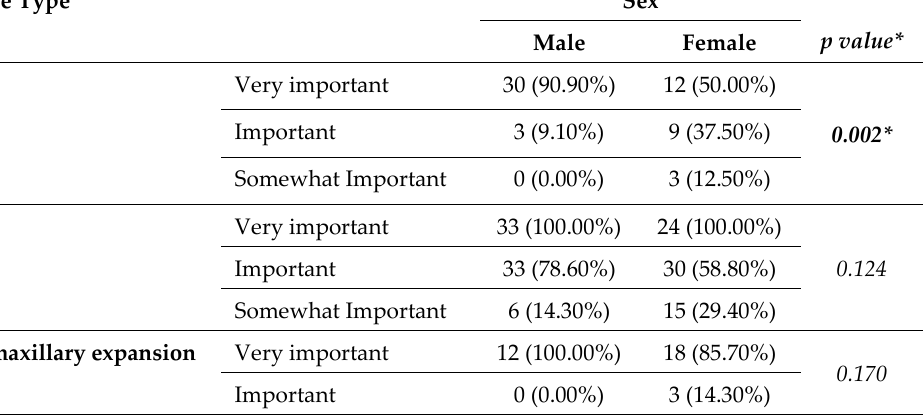
Table 4 : Consideration of orthodontist instruction according to device